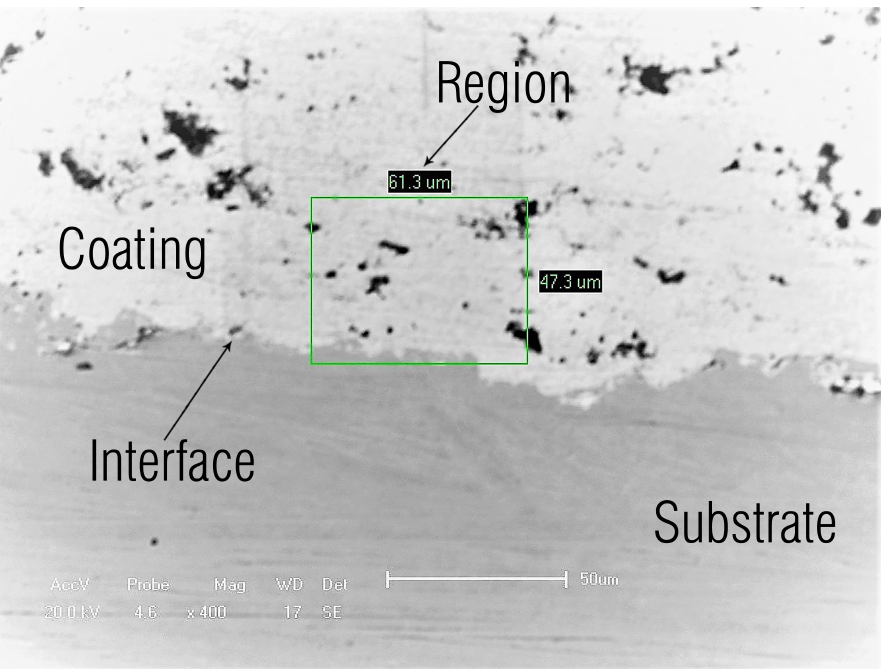
Figure 6. SEM image of the elemental microanalysis region in the cross-section of the HVOF 86WC-10Co4Cr coating using the EDS system (400 × ).